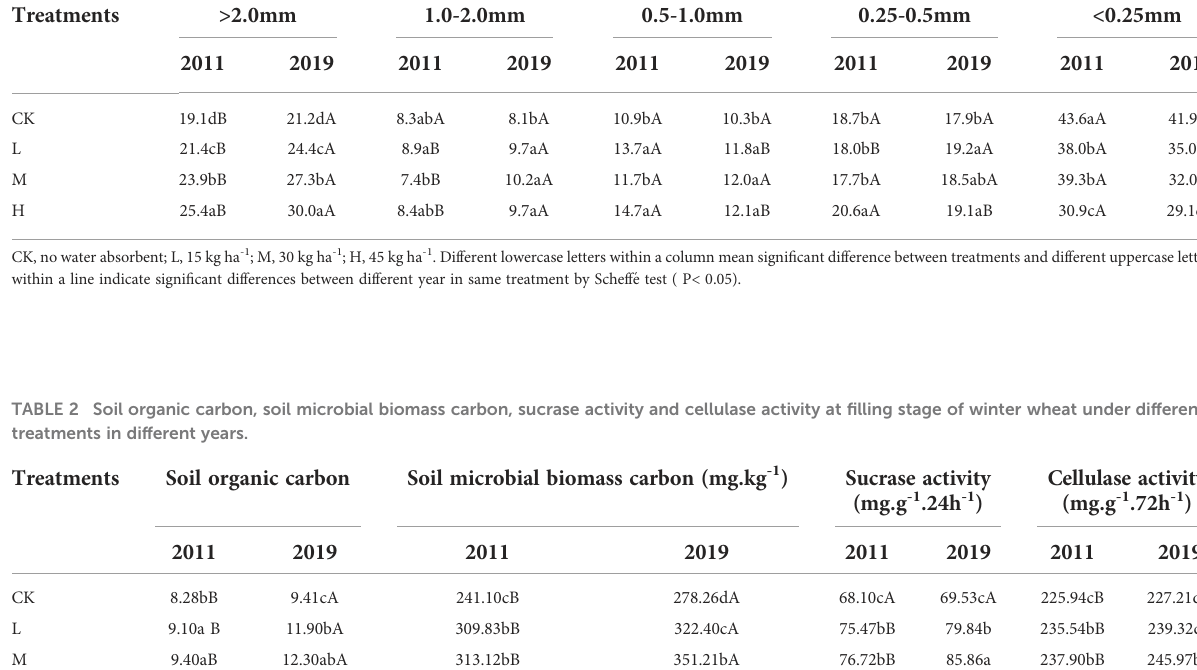
TABLE 1 The proportion of different diameters of aggregates under different treatments in different years. Treatments